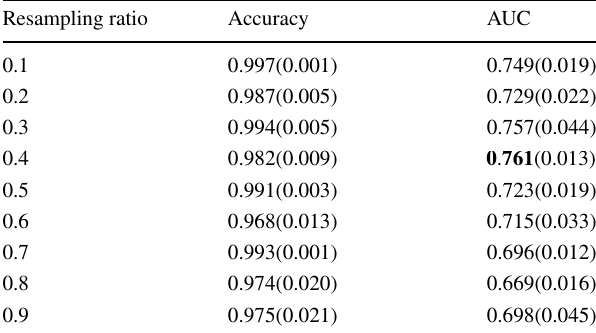
Table 7 The results of different resampling ratios in DMDP with LSTM (FIN) + Wavenet (TEXT)